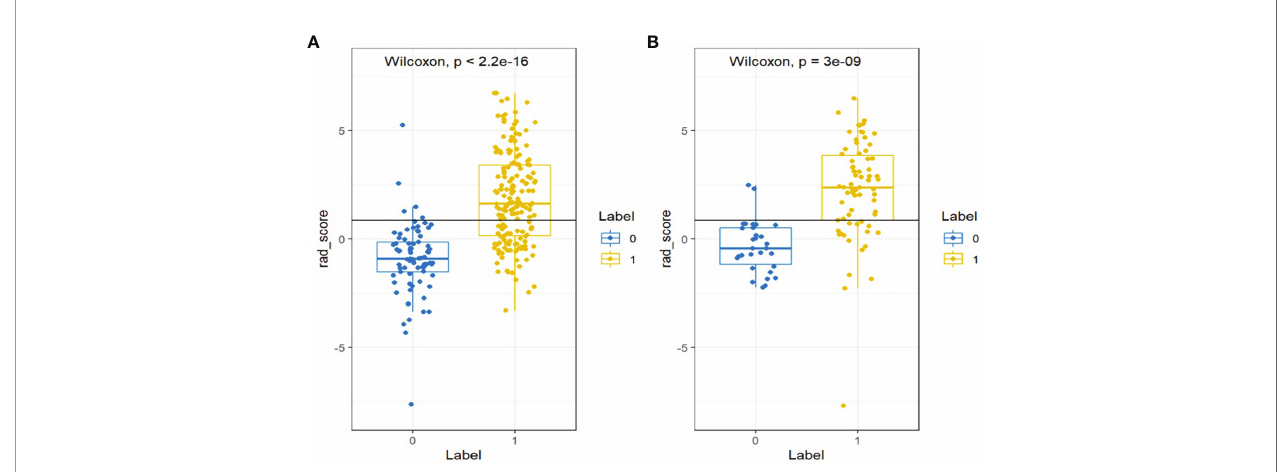
FIGURE 4 | Wilcoxon analysis of Rad-score for detecting the PM of GC in the (A) training cohort and (B) validation cohort (p < 0.05).